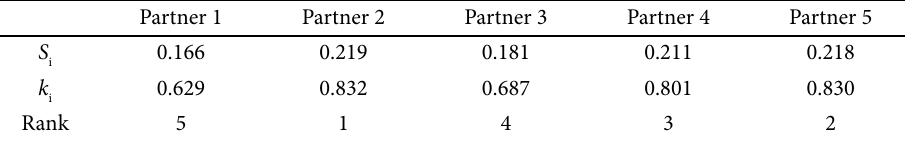
Table 14. The optimality function and the degree of an alternative value resulting from the ARAS-F method Partner 1 Partner 2